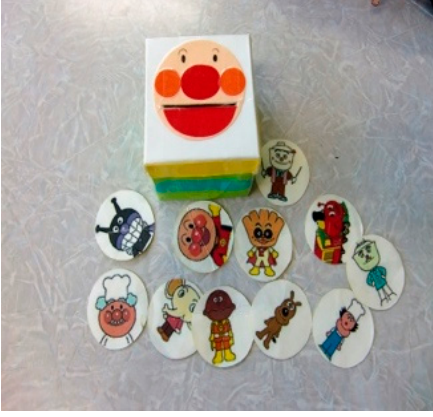
Figure 1. Anpanman savings box (created using a milk carton). Children 2018 , 5 , x FOR PEER REVIEW Figure 1: This handmade toy is a saving box shaped like Anpanman for children to enjoy touching original coins with various Anpanman characters drawn on and dropping them into the saving box. The coins with visually enjoyable drawings are also usable as cards.